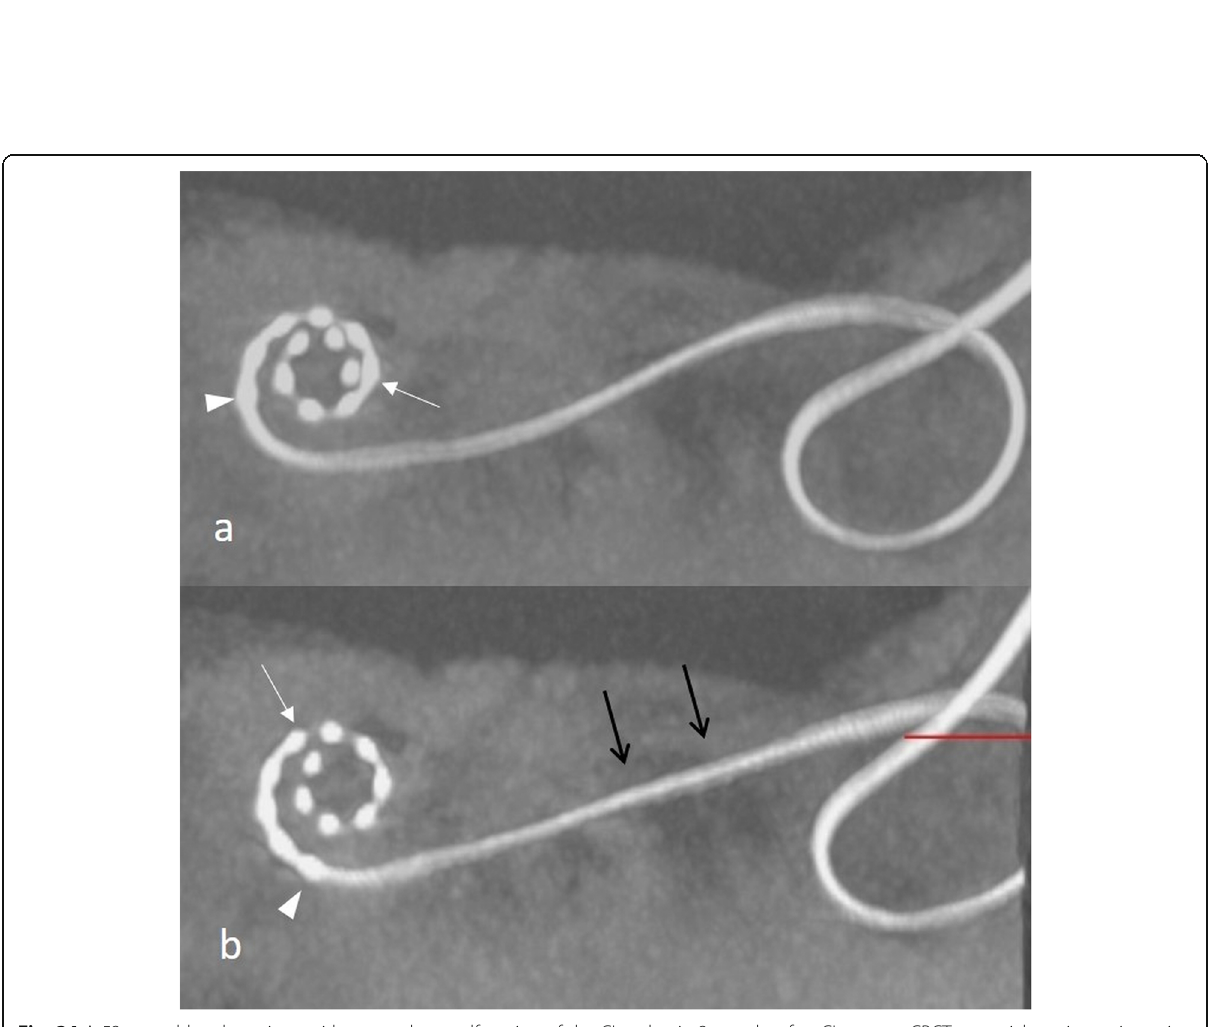
Fig. 34 A 53-year-old male patient, with a complete malfunction of the CI and pain 3 months after CI surgery. CBCT paraaxial maximum intensity projection image shows initial overinsertion of the electrode array ( a ). The control scan shows back extrusion of the electrode array with migrated positions of the electrode tip (arrow) and basal electrode element (arrowhead) and straightened electrode array (black arrows) in the mastoidectomy cave ( b